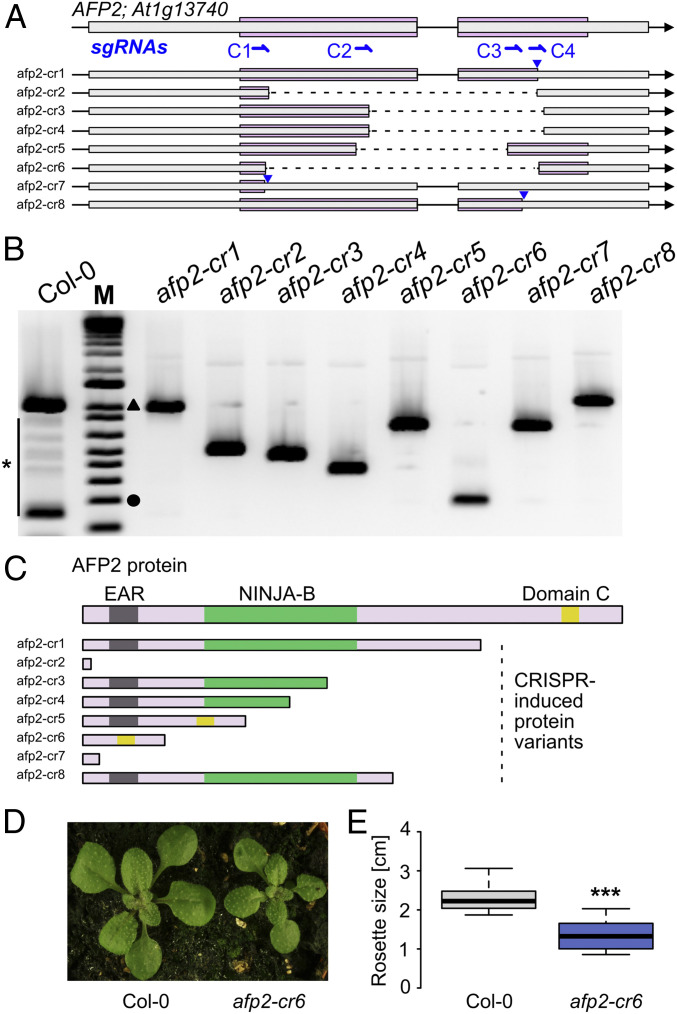
Creation of a LITTLE NINJA microProtein in Arabidopsis. (A) Gene model depicting the AFP2 locus with the coding sequence highlighted in pink. Four sgRNAs (C1 to C4) were designed and transformed as pools into Arabidopsis plants. Eight CRISPR-induced mutants (afp2-cr1-cr8) were identified. Dashed lines indicate deleted regions. Triangles depict point mutations. (B) RT-PCR showing amplification of the AFP2-coding region in wild-type and the eight afp2-CRISPR mutant plants. Star indicates spurious PCR products in wild-type. The circle depicts the 200 bp marker and the black triangle the 1.0 kb marker. (C) Protein model depicting the full-length AFP2 protein and the protein domains. The eight CRISPR mutants give rise to different protein isoforms. (D) Growth analysis of wild-type and afp2-cr6 T2 mutant plants revealed that afp2-cr6 plants showed reduced rosette sizes. (E) Rosette width of wild-type Col-0 and afp2-cr6 of 3-wk-old plants. Box plots show the observed experimental data. n = 8, ***P < 0.0005 determined by Student’s t test.